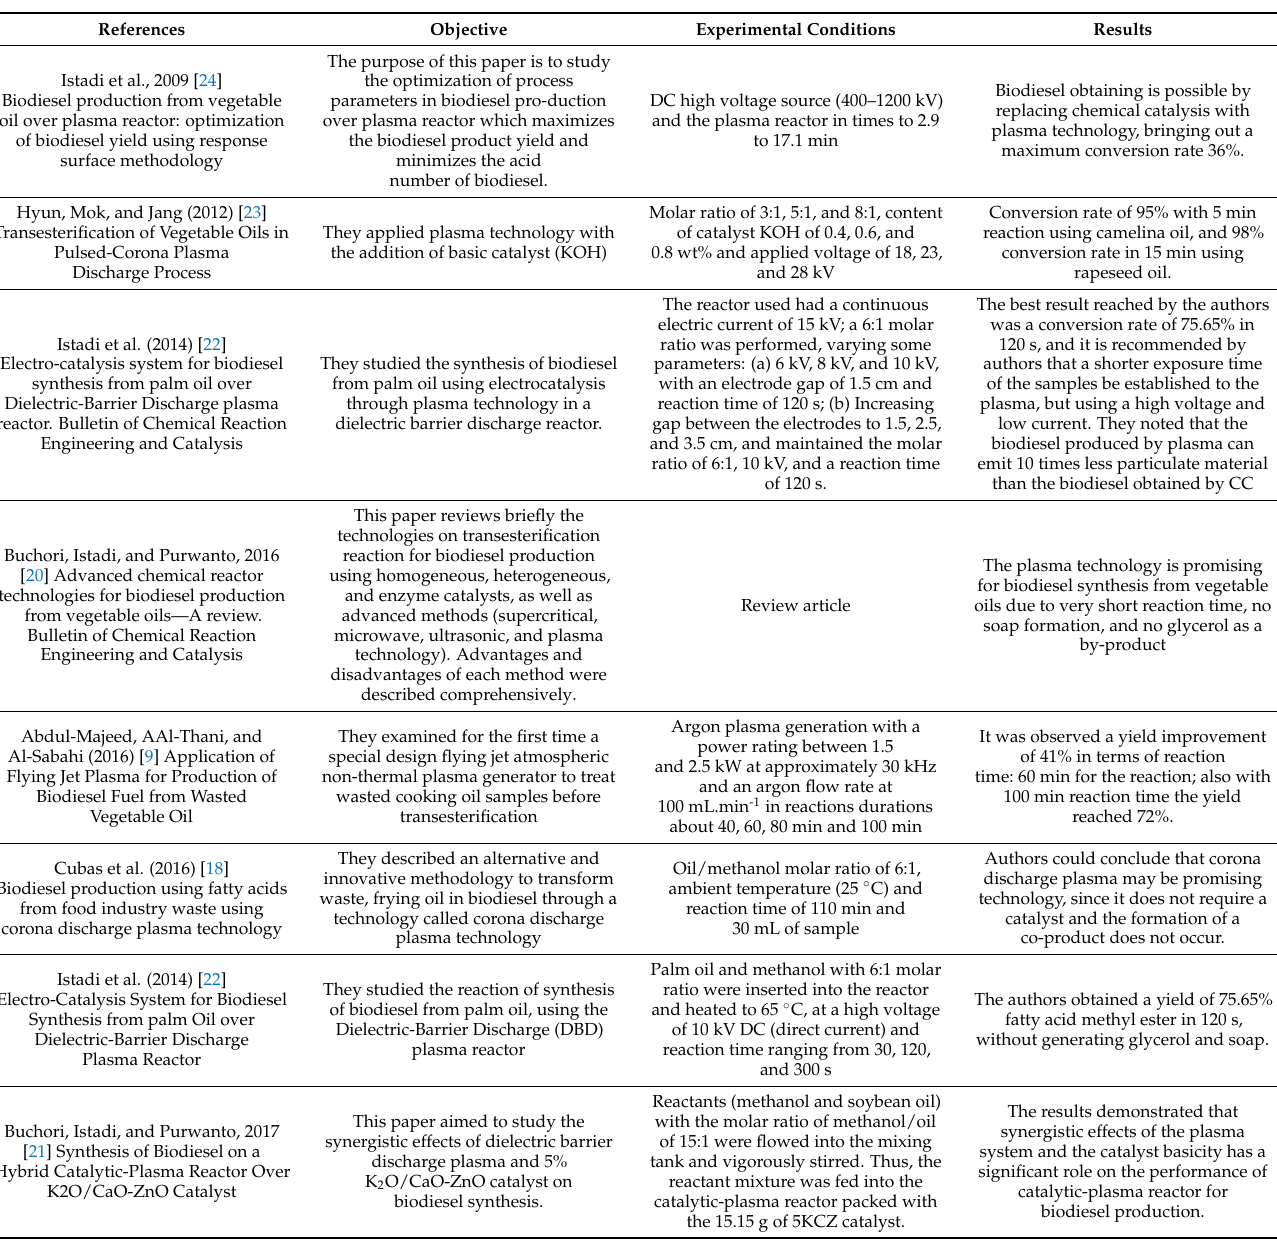
Table 1. References about the production of biodiesel by